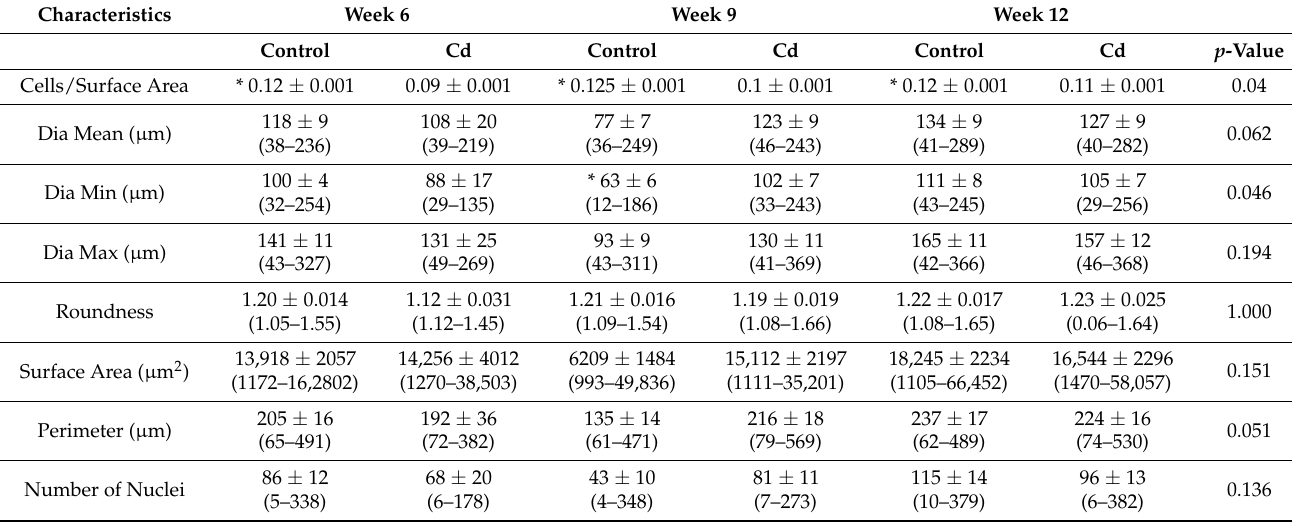
Table 2. Number of cells normalized to islet surface area were significantly lower in the Cd-treatment group at all time points examined: weeks 6, 9, and 12. Minimum diameter was also significantly different however, this was due to an unexplained decrease in the value for control-treated animals at week 9. Table 2. All values are mean ± SEM; ranges are also given underneath actual values. Data show changes in pancreatic islet morphology in animals exposed to Cd (0.6 mg/kg/day) for up to 12 weeks and saline-control animals. Pancreata from a minimum of four animals from each treatment group and time point were examined.